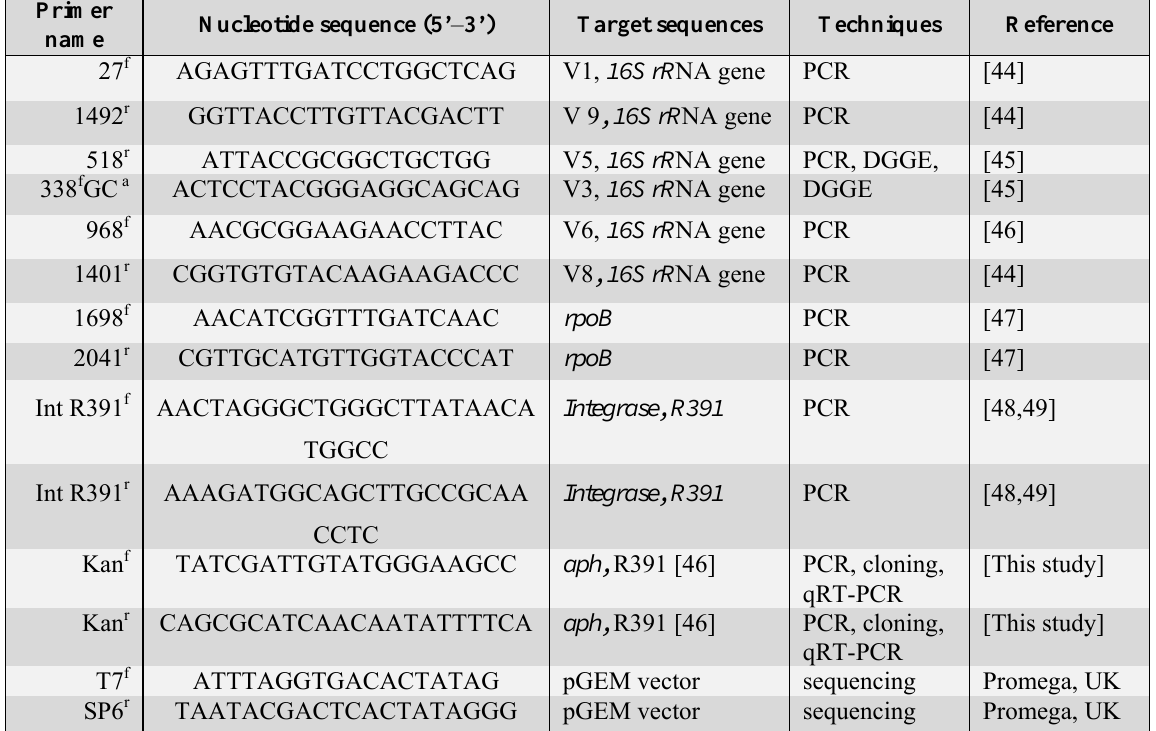
Table 1. Oligonucleotides used in this